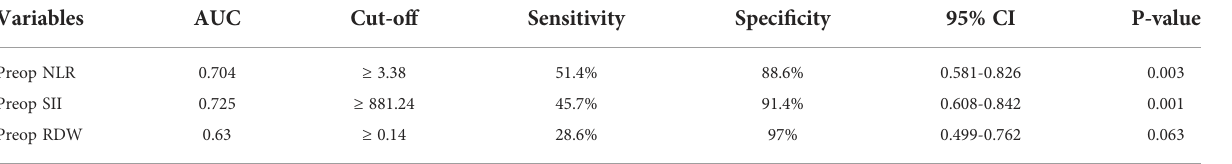
TABLE 3 Cut-off, AUC, sensitivity and speci fi city values of NLR, SII and RDW. Variables AUC